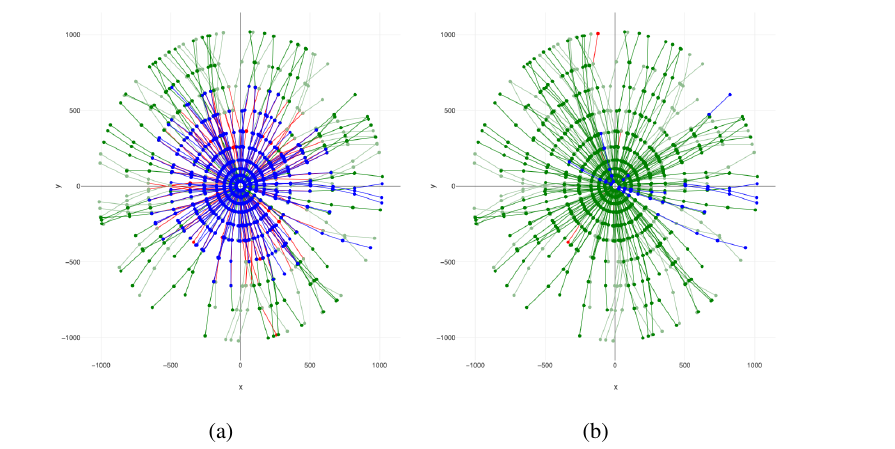
Figure 2: An example of doublets on x-y place in one collision event (a) before QUBO solving (b) after QUBO solving. Dark (light) green line shows a reconstructed doublet within (without) the momentum acceptance. Blue line shows a missing doublet, which should be reconstructed but not remain after QUBO solving. Red line shows a fake doublet, which is not associated with injected tracks and remains after QUBO solving. Since the catego- rization of doublets is evaluated after connecting the neighbor doublets, a badly connected doublet with wrong neighbor doublets is identified as a missing.